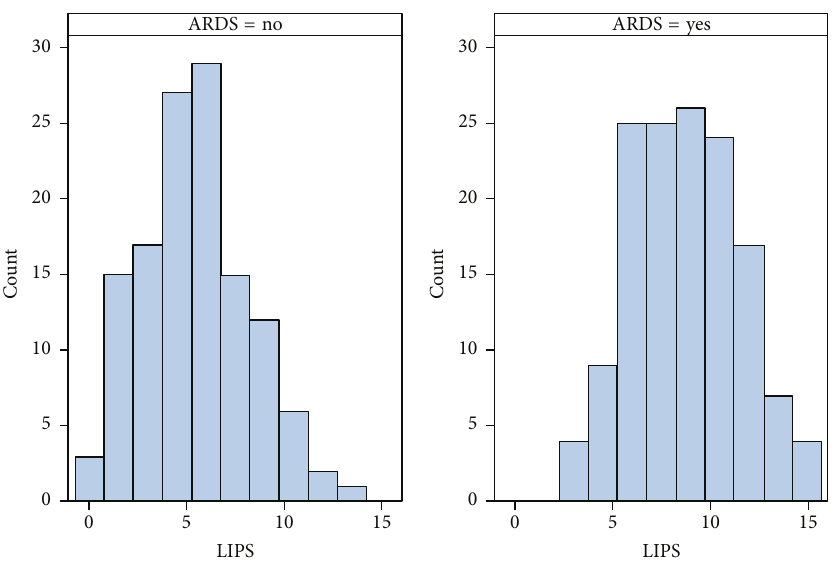
Figure 1: Distribution of LIPS for patients with and without the development of ARDS. Distribution of LIPS for patients who develop and do not develop ARDS. Patients with ARDS tend to have higher LIPS values.